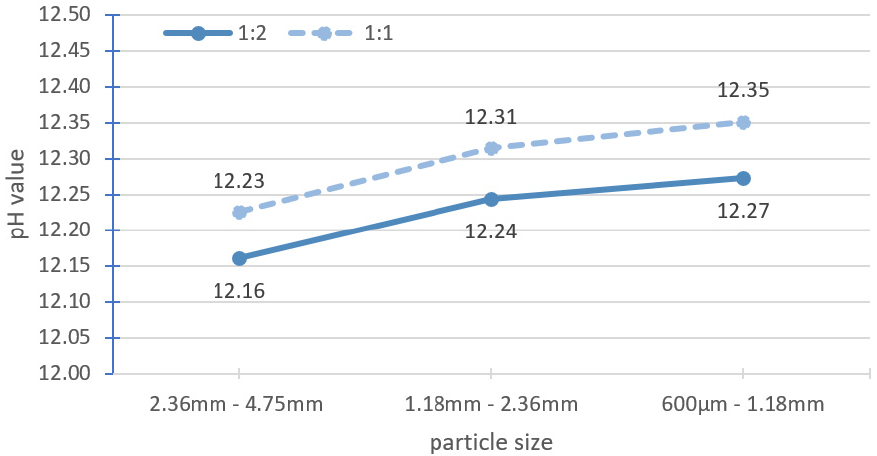
Figure 6. Effect of solid-to-solvent ratio of 1:1 and 1:2 for large particle size.